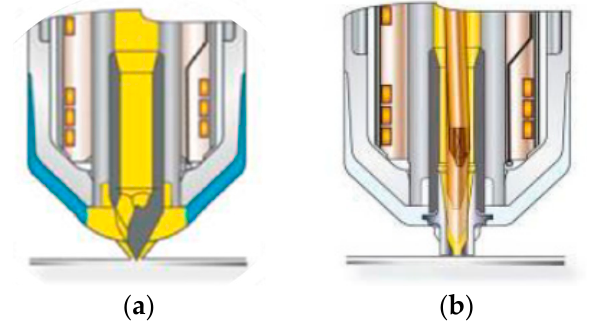
Figure 2. Schematic representation of the open hot runner system with tip ( a ) and the valve gate hot runner system ( b ).